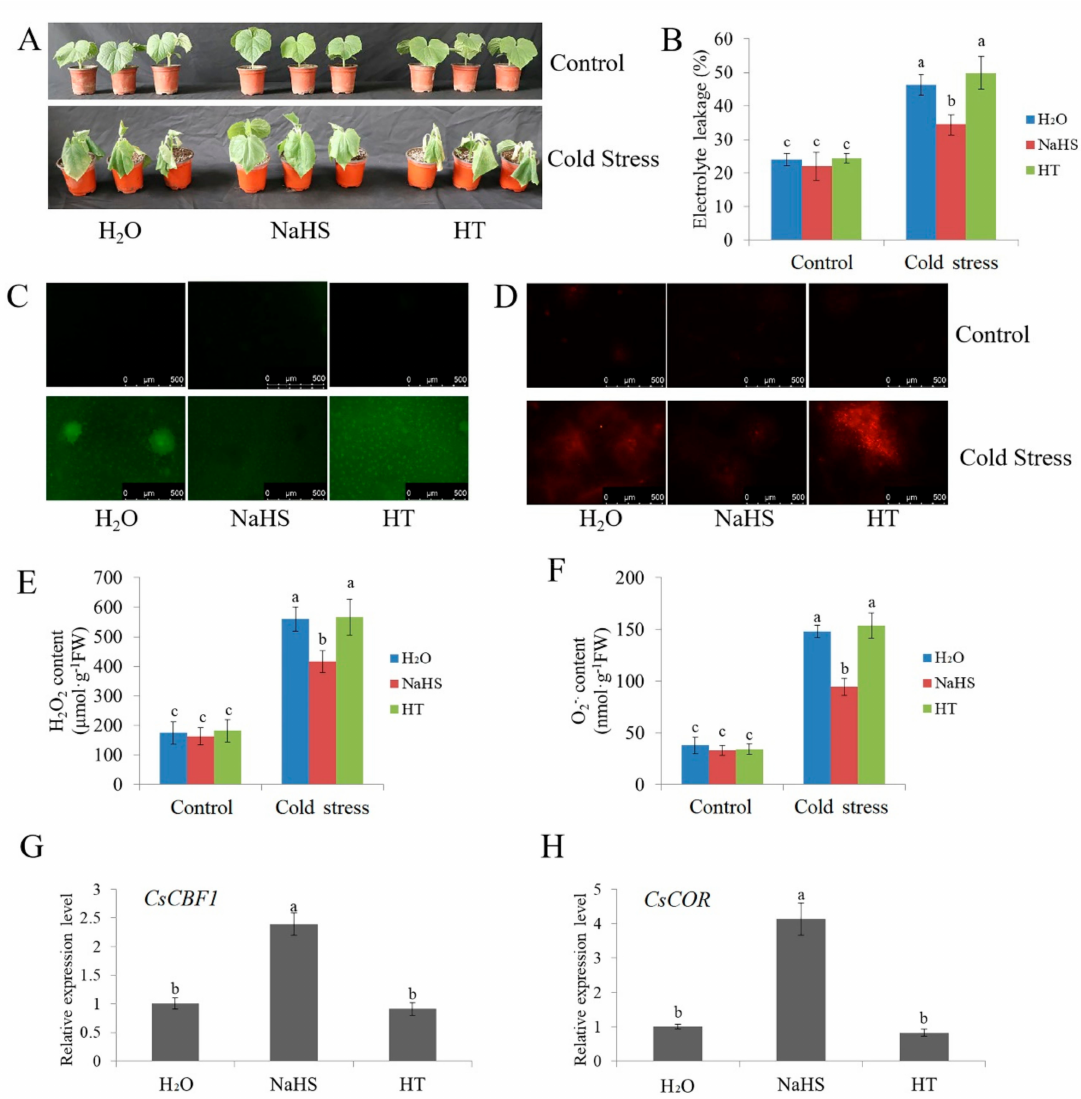
Figure 1. Effects of NaHS and HT on the cold tolerance of cucumber seedlings. Cucumber seedlings were treated with NaHS, HT or deionized water for 24 h and subsequently were exposed to cold stress. ( A ) Phenotypic characterization of cucumber seedlings before (control) and after cold stress (5 ◦ C for 48 h). Each treatment contained 5–10 cucumber